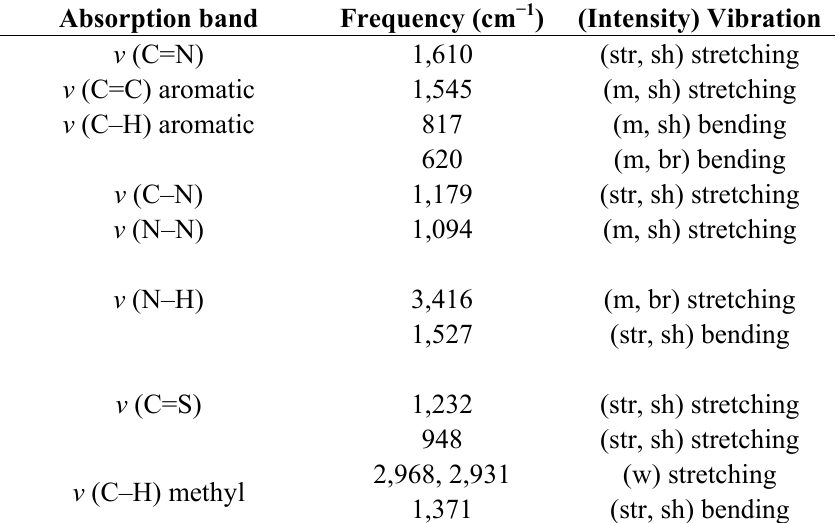
Table 1. Summary of FT-IR analysis of